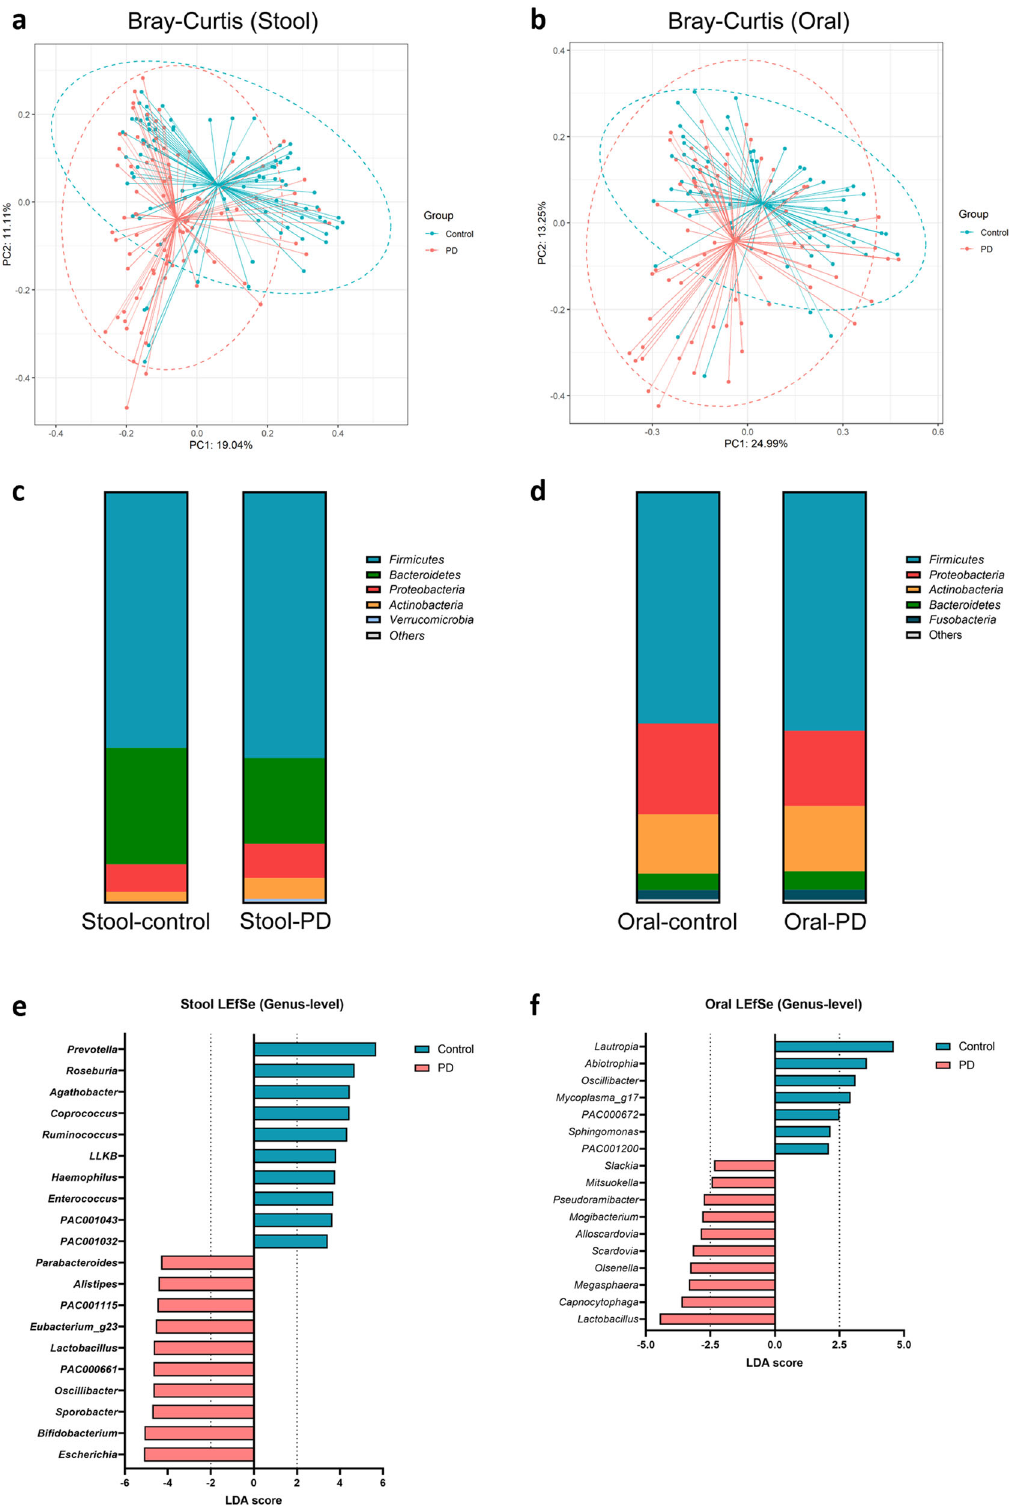
Fig. 1 Gut and oral microbial community structure based on 16 S rRNA gene sequencing. a , b Principal coordinates analysis based on the Bray-Curtis dissimilarity between Parkinson ’ s disease (PD) and healthy controls in a stool and b oral samples. c , d Phylum-level bar charts of PD and HCs in the c stool and d oral samples. e , f Comparison of the e gut microbiome and f oral microbiome between PD and HCs using genus- level LEfSe analysis. The top 10 genera based on the LDA score in the PD and control groups are shown. The cut-off value for oral LDA effect size was set at 2.0. LLKB ( Lachnospiraceae ; LLKB01000001), PAC001043 ( Lachnospiraceae , AJ576336), PAC001032 ( Lachnospiraceae , unpublished), PAC001115 ( Christensenellaceae , HQ716403) PAC000661 ( Oscillospiraceae ; JN713389) PAC002046 ( Lachnospiraceae , GQ897562), and Eubacter- ium _g23 ( Oscillospiraceae , GQ502529) were the phylotype genera (Family, NCBI accession number).